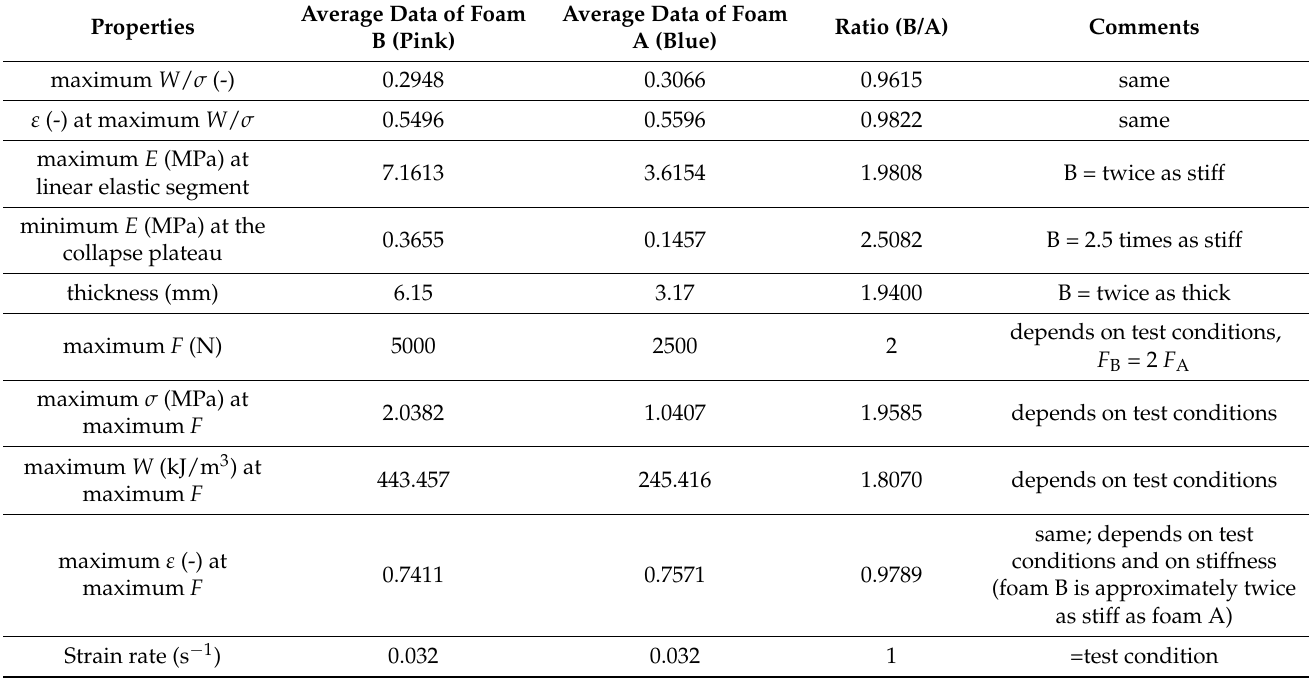
Table 1. Comparison of energy absorption per unit volume ( W ), strain ( ε ), and stress ( σ ) of foams A and B.